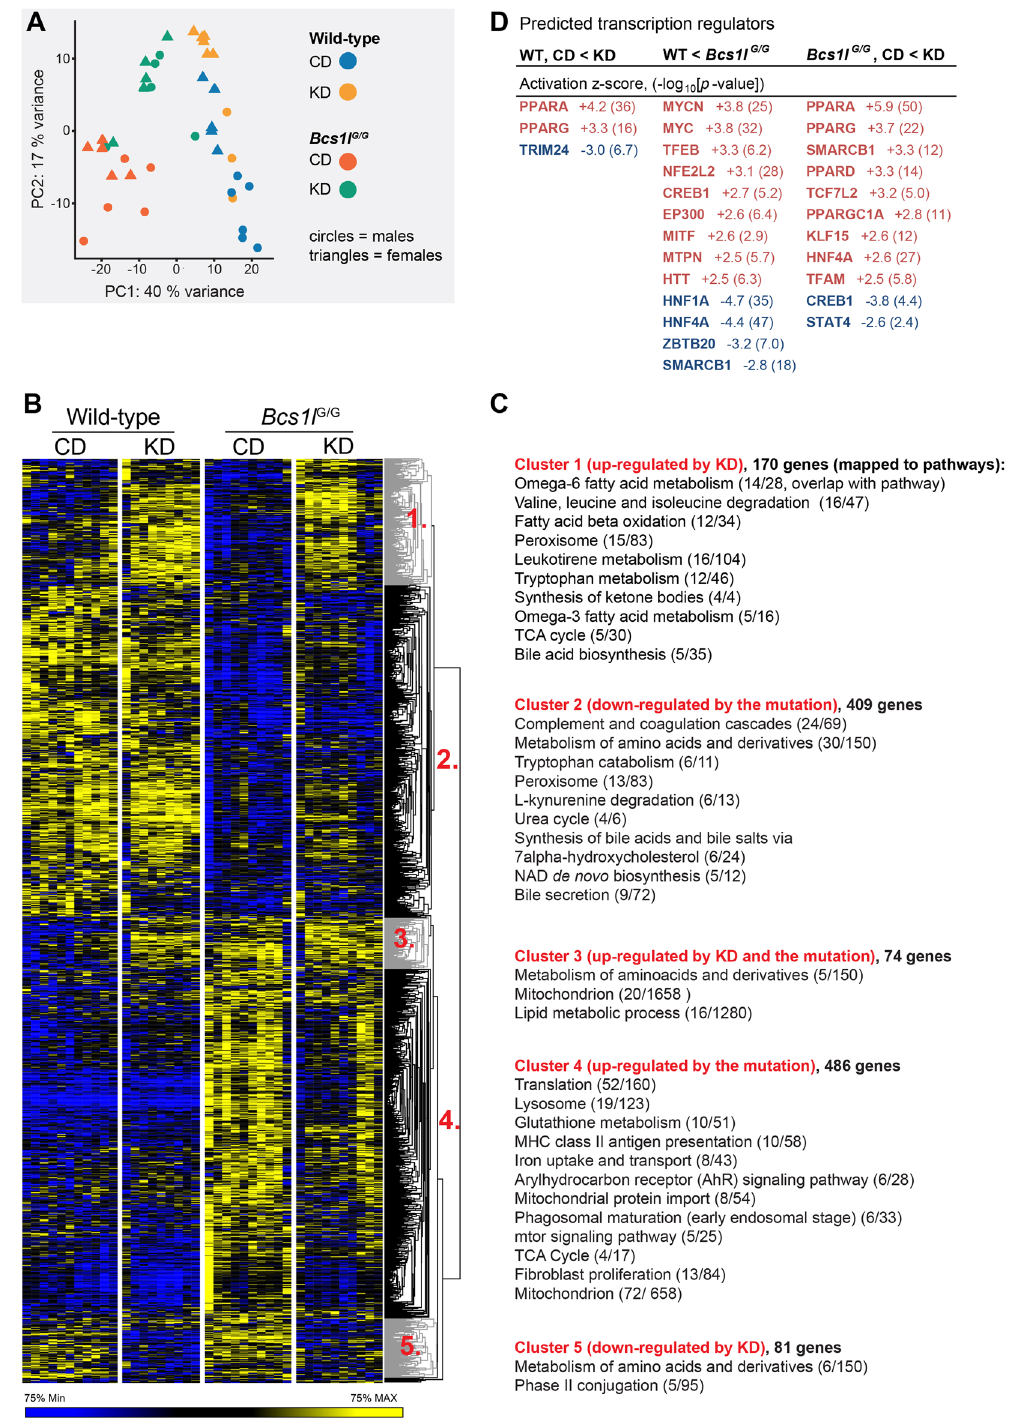
Figure 5. Liver transcriptome is distinctly altered by the Bcs1l mutation and the diet. ( A ) Principal component analysis of 500 most variable transcripts shows separation of WT and mutant mice (PC1) and partial separation of dietary groups and gender (PC2). ( B ) Heat map of differentially expressed genes. Nineteen genes had significant gender-genotype interaction (not shown in the heatmap) ( C ) A pathway analysis of the gene clusters. (D ) The most significant transcriptional regulators predicted to drive the observed gene expression